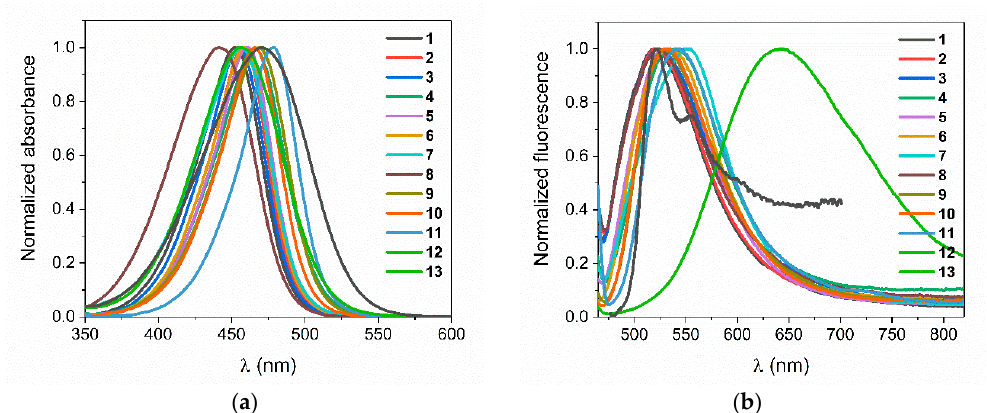
Figure 2. Normalized electronic absorption ( a ) and one-photon fluorescence ( b ) spectra of 1–13 in EtOAc at room temperature (RT); λ Ex = 450 nm.